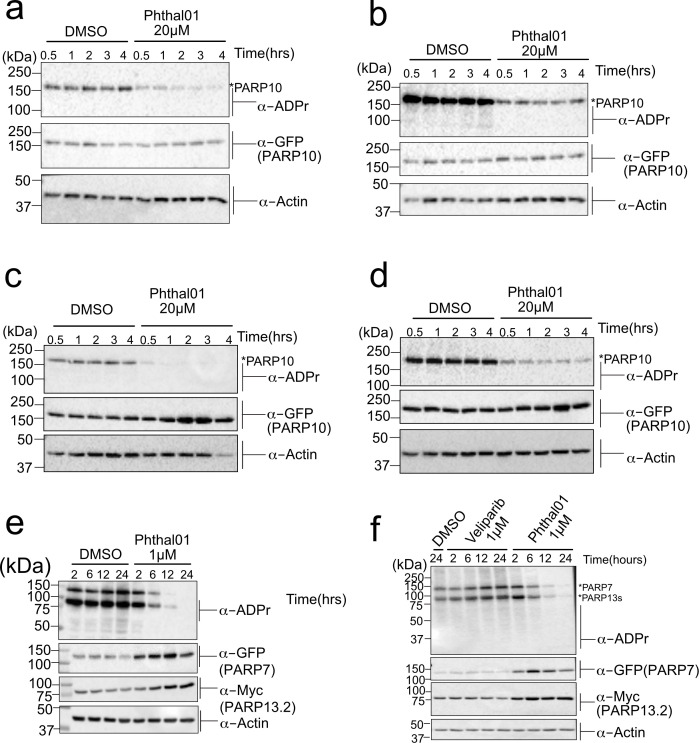
PARP-13.2 Cys MARylation is more stable than PARP-10 Asp/Glu MARylation in cells.(a–d) Biological replicates of time course inhibition post in-cell (HEK 293T) expression of GFP-PARP-10 using Phthal01 (20 μM). (e–f) Biological replicates of time course inhibition post in-cell (HEK 293T) expression of PARP-7 using Phthal01 (1 μM). See legend of Figure 4D–F.